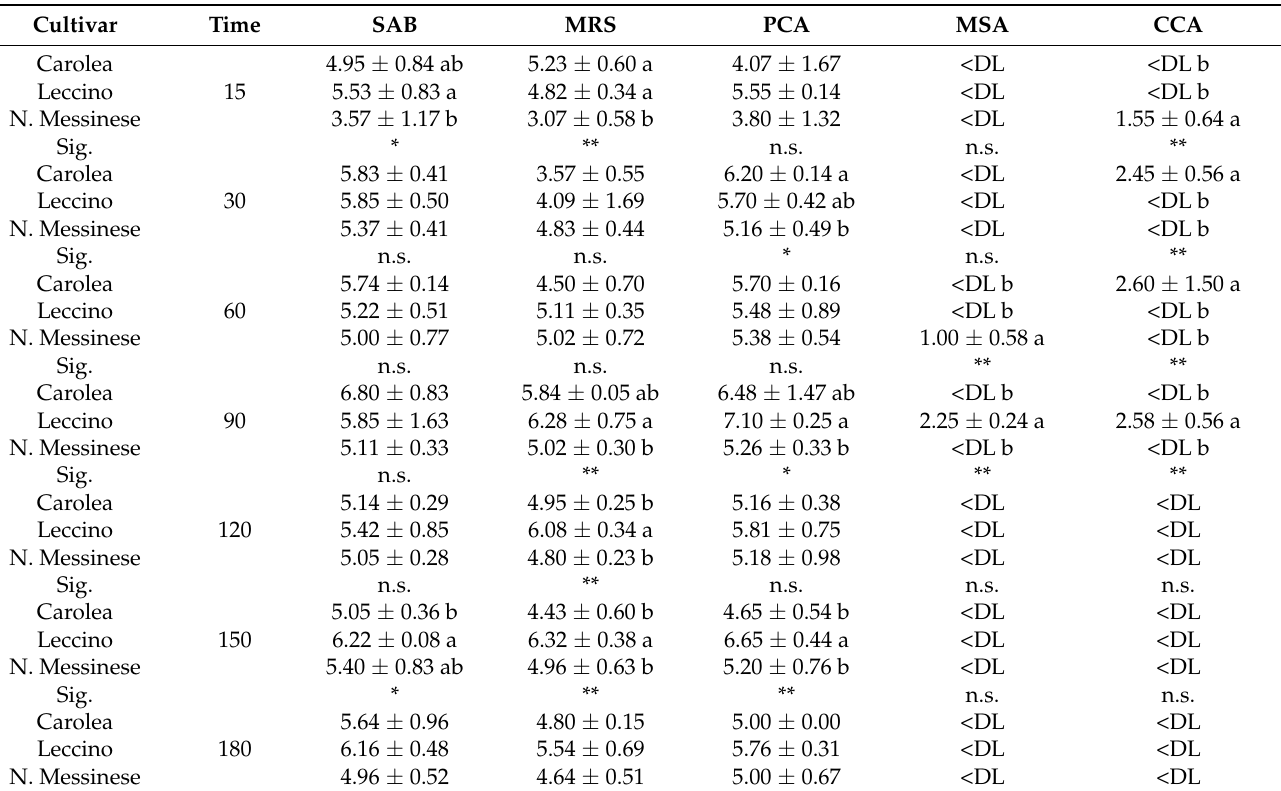
Table 5. Microbial log counts of yeasts and moulds (SAB), lactic acid bacteria (MRS), total viable